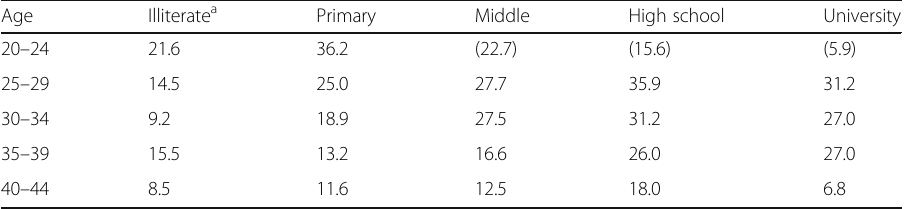
Table 7 Percentages ever-cohabiting among all women, by age and completed level of education, People ’ s Republic of China, 2014 Age Illiterate a Primary Middle High school